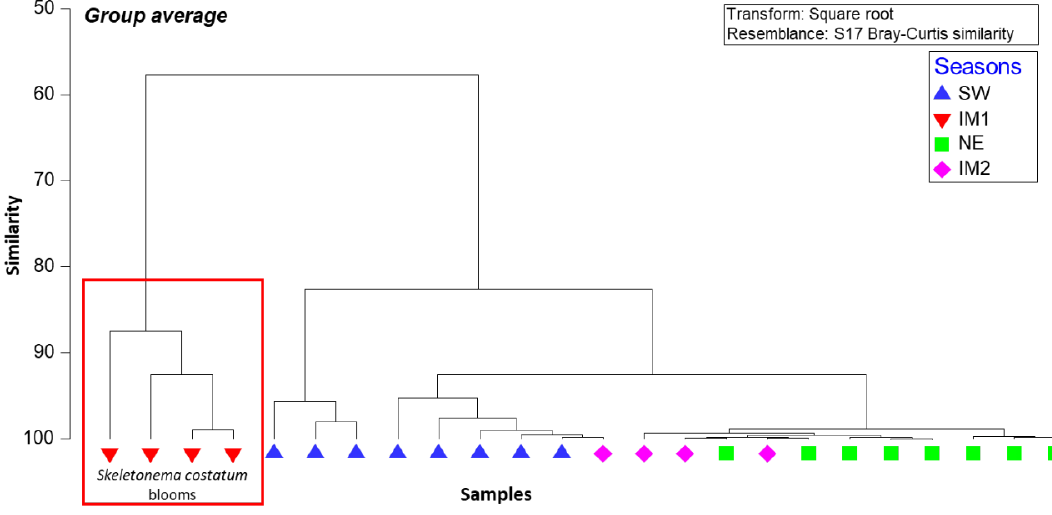
Figure 4. Hierarchical clustering of Shannon–wiener diversity index (H’) using group-average linking 24 phytoplankton samples of Bray Curtis dissimilarities according to seasons. A group of samples during the intermonsoon in October (IM1), separated at 60%, was associated with the massive blooms of Skeletonema costatum .